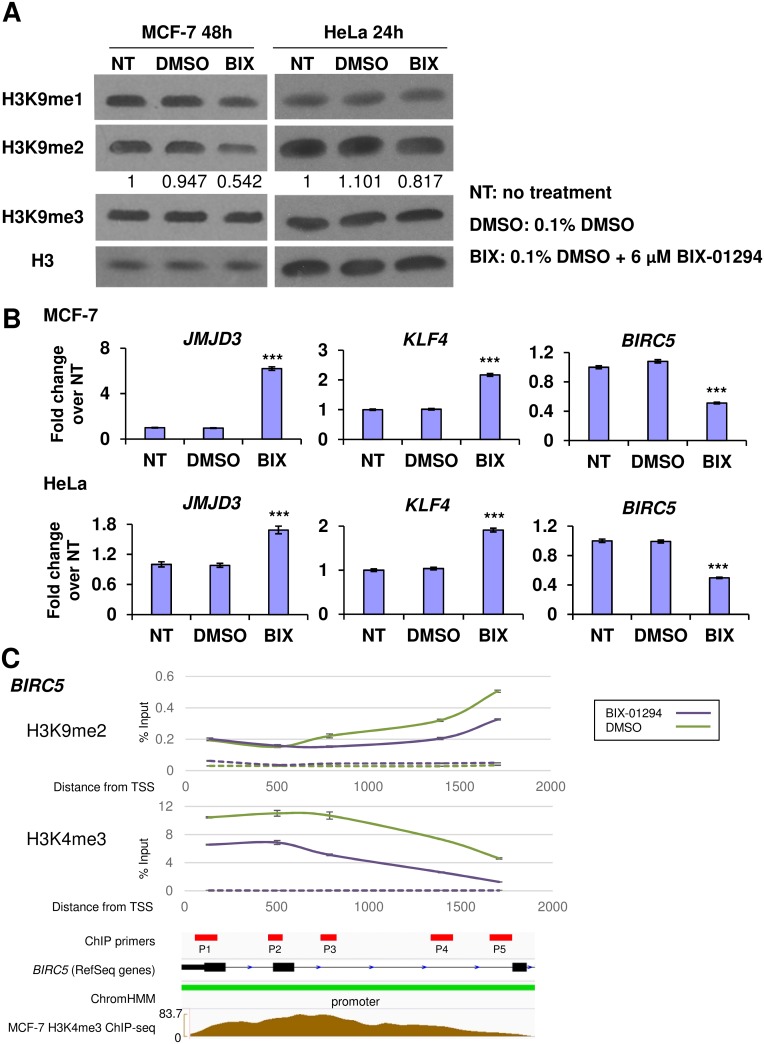
BIX-01294 attenuates H3K9 methylation and derepresses transcriptional regulation of target genes.(A) Western blots showing decrease in H3K9me1 (MCF-7) and H3K9me2 levels (MCF-7 and HeLa) after 48 and 24 hours respectively in the indicated treatments. Total histone 3 (H3) was used as the loading control. Numbers indicate band quantification of the relative levels of H3K9me2 to that of the NT control after normalization to H3. (B) Fold change in gene expression of JMJD3, KLF4 and BIRC5 in MCF-7 and HeLa cells treated with 6 μM BIX-01294 (BIX) compared to the NT and DMSO controls. Gene expression levels were normalized against the housekeeping reference gene EEF1G and fold change was calculated against the average of the NT controls. Error bars show SEM for n = 6 replicates. (C) ChIP-qPCR results showing enrichment of H3K4me3 and H3K9me2 around the TSS of BIRC5 in MCF-7 cells treated with 6 μM BIX-01294 (purple) compared to the DMSO control (green). ChIP samples were normalized against the input control. Dotted lines show IgG controls for the respective treatments. Integrative Genomics Viewer (IGV) traces show the location of primers (red rectangles), exons (black rectangles), introns (connecting black lines with blue arrows indicating transcription direction), promoters (green rectangle) and H3K4me3 enrichment (brown) respectively for BIRC5.